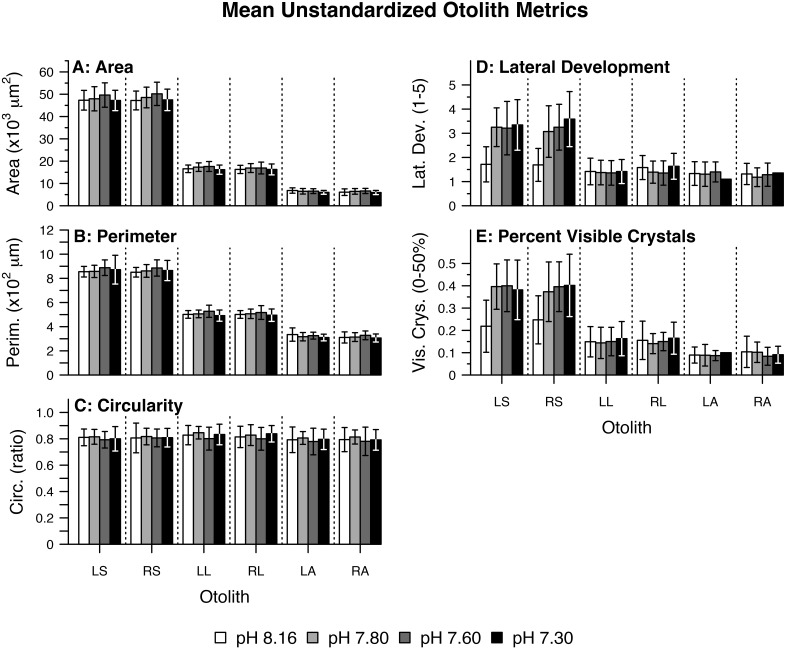
Mean unstandardized otolith metrics.Summary of raw (fish-level) otolith morphological data including (A) Area, (B) Perimeter, (C) Circularity, (D) Lateral Development, and (E) Percent Visible Crystals by pH/pCO2 treatment (legend) and otolith type/side. Otolith name abbreviations are identical to those elsewhere in the manuscript (e.g., LS for Left Sagittae). Bars represent combined means. Lines represent one (pooled) standard deviation.